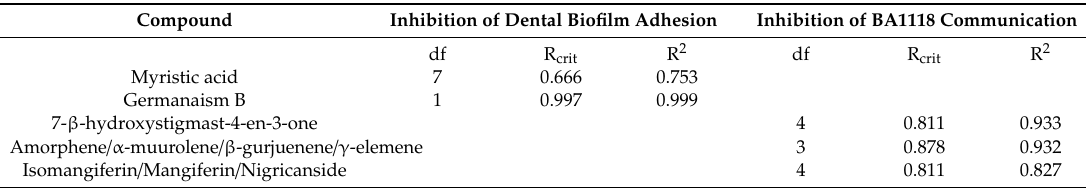
Table 5. Correlation coe ffi cients (R 2 ) of dependence of biological activity of 15 Iris extracts on HRMS / MS responses of compounds detected and tentatively identified by targeted UHPLC–HRMS / MS screening. Note: only substances for which the correlation was significant are presented. Compound Inhibition of Dental Biofilm